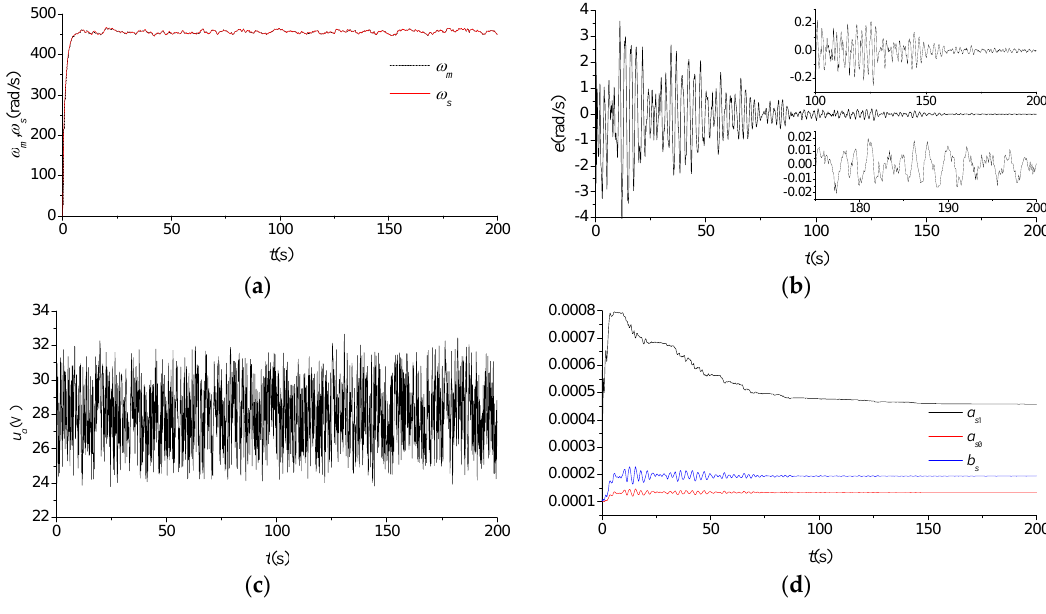
Figure 7. Flight test results. ( a ) ω m and ω s ; ( b ) e ; ( c ) u a ; and ( d ) the parameters of the soft sensor.